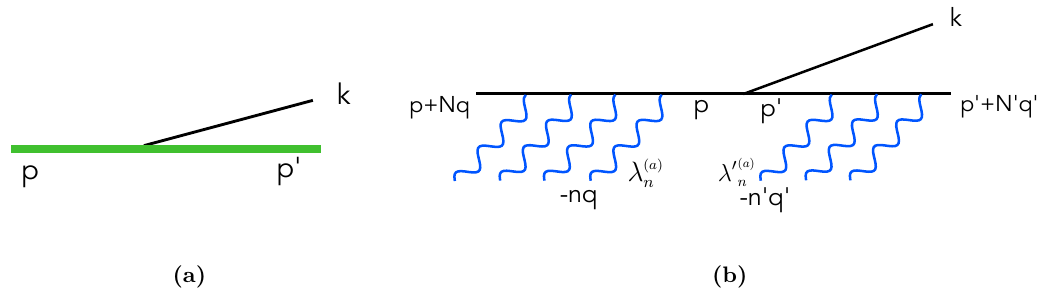
Figure 4. (a) We compute the amplitude of a string of momentum p , in some definite excited state, to decay into another string of momentum p 0 in a definite excited state, via emission of a tachyon of momentum k . The amplitude depends on the angle θ of the outgoing string and tachyon, and the polarizations of the ingoing and outgoing strings. (b) This amplitude is extracted from the amplitude involving a large number of “DDF photons” of momenta that are integer multiples of a null vector q . These photons can be thought of as creating the excited string. The precise state of the excited string sets the polarizations and momenta of the DDF